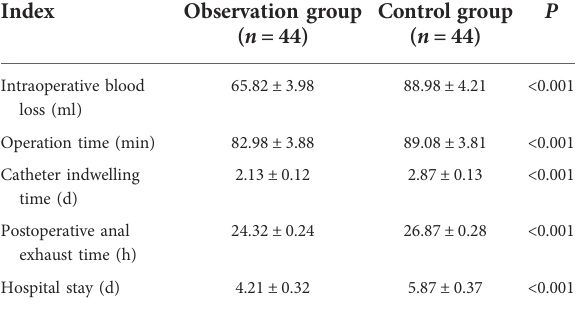
TABLE 2 Comparison of indexes in the perioperative period between the two groups.